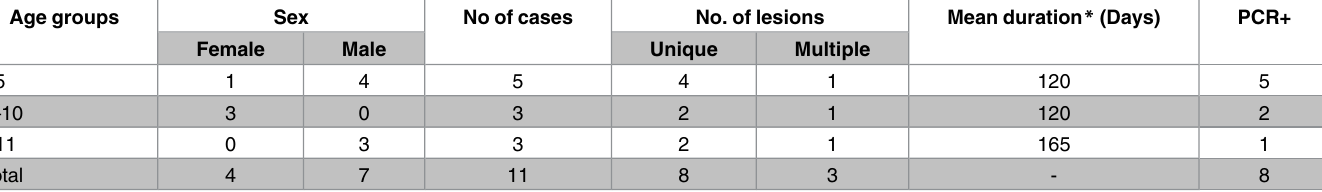
central and southeast Mali, respectively. Our data showed a higher prevalence of LST+ in all the villages located in the Sahelian district of Diema compared to those in the district of Kolo- kani in central Mali and Kolondieba in southern Mali. Indeed, the overall prevalence of LST in ages 19 to 65 years was 84.2% (N = 101) in Nafadji, 85.0% (N = 80) in Guemou, 87.9% (N = 91) in Debo Massassi and 82.1% (N = 56) in Tinkare. In Tie´nekebougou located in the district of Kolokani, central Mali, LST prevalence was 24.6% (N = 175), while in Boundioba in the district of Kolondieba, southern Mali, it was only 2.7% (N = 224). This north to south decrease in the prevalence of LST+ can be partly explained by the same pattern of decrease observed in the densities of P . duboscqi , the Phlebotomus species incriminated in the transmis- sion of CL in Mali [13]. In a study carried out ten years ago in Baroueli, a neighboring district of Kolokani, Oliveira et al [10] observed a LST positivity ranging from 45.4% to 19.9% suggest- ing that transmission is stable in central Mali.